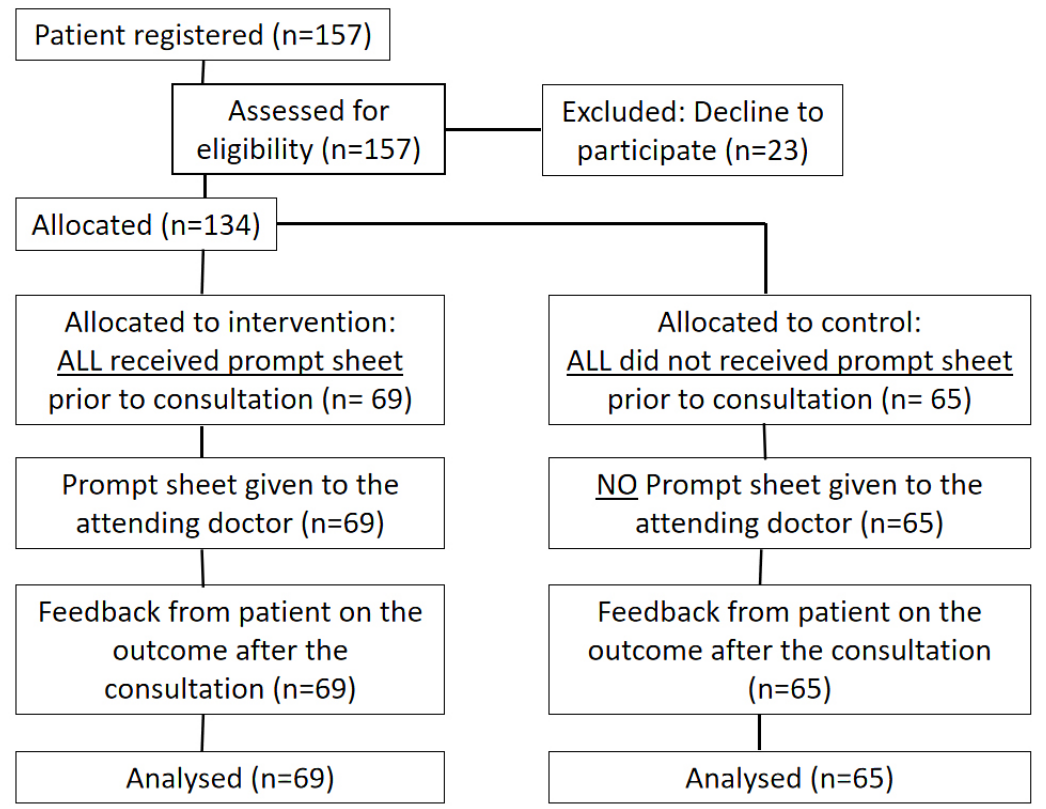
Fig. 1. Study flow